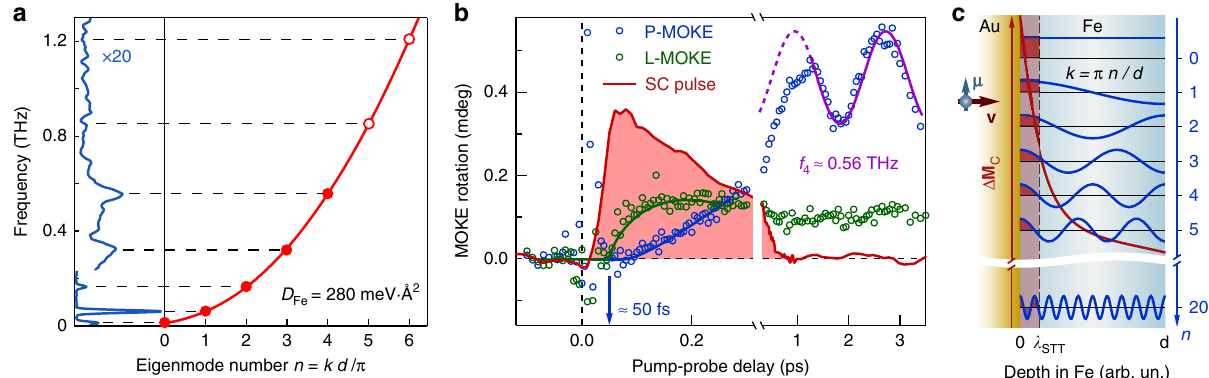
Figure 4 | Excitation of the standing spin waves. ( a ) Fourier spectrum of the experimental data shown in Fig. 3, averaged over several datasets (left panel). Red solid line (right panel) is the calculated spin waves dispersion curve from equation (2) with the indicated magnon stiffness D Fe . The frequencies of the standing spin waves in a 14nm-thick Fe film are shown in the right panel with red symbols. Along with the fundamental uniform precession ( n ¼ 0), four higher modes are shown which were detected in the experiment (full dots). The dashed lines illustrate the agreement between the frequencies of the Fourier peaks and those of the standing spin waves. ( b ) Transient MOKE rotation data on the ultrashort timescale. The rapid onset of the longitudinal component (green circles) is followed by a slower increase of the polar one (blue circles) due to the magnetization precession around its equilibrium. The red shaded area reproduces the SC pulse as measured in ref. 5. The purple line illustrates the 4th spin wave eigenmode with the frequency f 4 observed in the transient polar MOKE component. ( c ) Excitation of the higher eigenmodes is limited by the spatial in-depth profile of the STT perturbation M C (red curve). The excitation region with a characteristic depth l STT is sketched by the red shaded area. The excitation efficiency given by the convolution of the STTexcitation profile and the in-depth profile of a particular standing spin-wave eigenmode (blue curves) is represented with red and blue shaded areas. In the case of a homogeneous precession (the top eigenmode with n ¼ 0), this overlap is always non-zero. The eigenmodes with small non-zero n are still excited albeit with smaller efficiency. However, for the eigenmode with a large n (bottom, n ¼ 20), the convolution yields positive and negative regions (red and blue shaded areas), which cancel each other out, thus greatly reducing the excitation Methods transmission electron microscopy revealed excellent epitaxial quality and flatness of Sample fabrication . Epitaxial Fe/Au/Fe structures with 15 and 16nm Fe layers and interfaces 5 (see Supplementary Note 4 and Supplementary Fig. 3). 55nm Au spacer capped with 3nm of Au were grown on optically transparent MgO(001) substrates with a thickness of 0.5mm. The substrates were cleaned in the Magnetic characterization . Before the time-resolved experiments, magnetic prop- ultrasonics baths of ethanol, isopropanol, acetone (15min each at elevated temperature erties of the samples were characterized by means of the static MOKE measurements. of E 310K). After being mounted in an ultra-high vacuum chamber, the substrates were The hysteresis loops of the MOKE rotation and ellipticity were obtained from both sides exposed to oxygen with a partial pressure of 2 (cid:2) 10 (cid:5) 3 mbar at a temperature of 540K of the samples (see Supplementary Note 5 and Supplementary Fig. 4). The sample was for 30min to remove spurious amounts of diamond polish left by the last fabrication placed in such a way that its easy anisotropy axes were oriented along the longitudinal step. With ultra-high vacuum conditions reached, Fe and the first nanometre of the and transverse magnetic field directions. During the measurements, a longitudinal interstitial Au layer were evaporated at 460K. The samples were then cooled down and magnetic field was scanned from (cid:5) 20 to 20Oe, while a weak auxiliary magnetic field the additional amount of Au was evaporated at room temperature. Transparent sub- up to 5Oe was applied in the transverse direction. Both fields were produced by strate and thin capping Au layer provided optical access from both sides. The scanning electromagnets. This procedure allowed us to realize the two-step switching of the